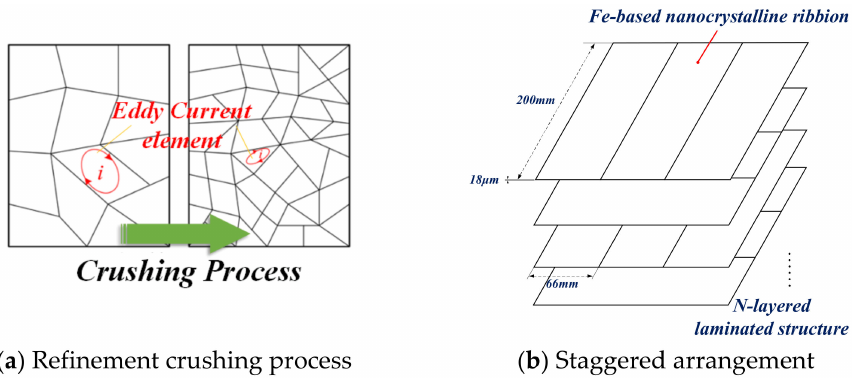
Figure 19. ( a , b ) Two processes to reduce additional eddy current loss in nanocrystalline